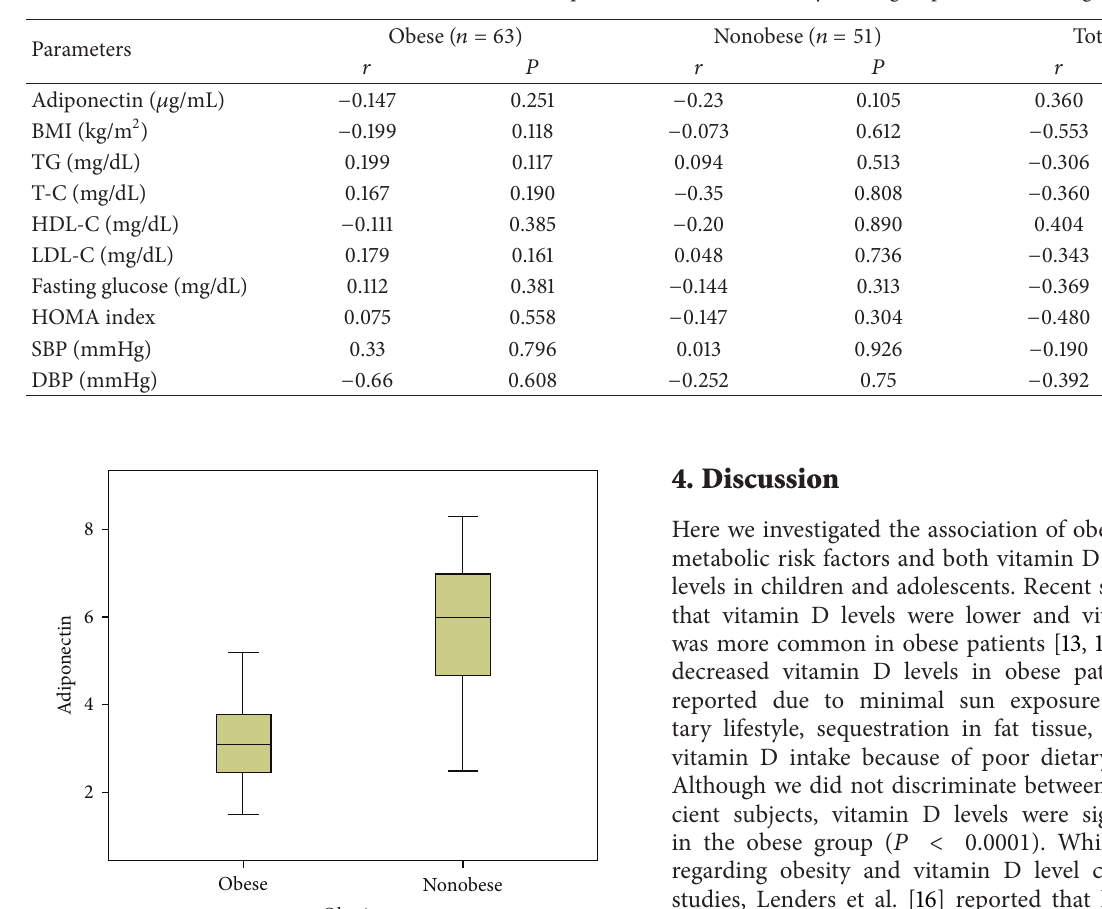
Table 3: Correlations of 25(OH)D with other parameters of the total study, obese group, and nonobese group.